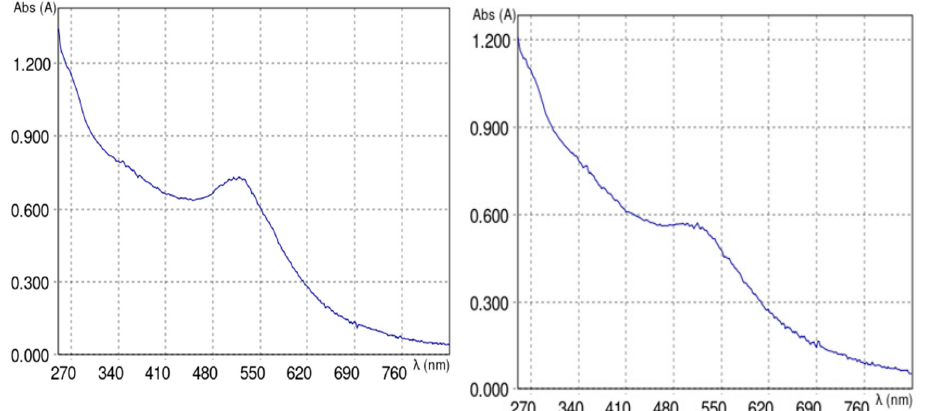
Figure A7. AuNP-PEG 1 (A spr = 0.730/A 450 = 0.633 give 1.15 → 3–4 nm) after dialysis with typical absorption maximum for ultrasmall AuNPs at 514 nm ( left ). AuNP-maleimide 2a ( right ).